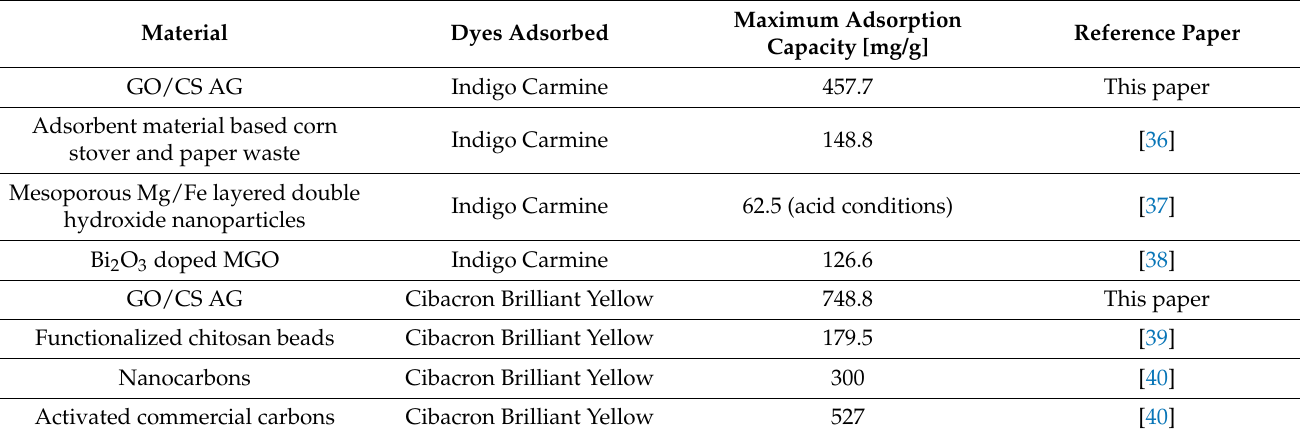
Table 2. Performances obtained in this work compared with the